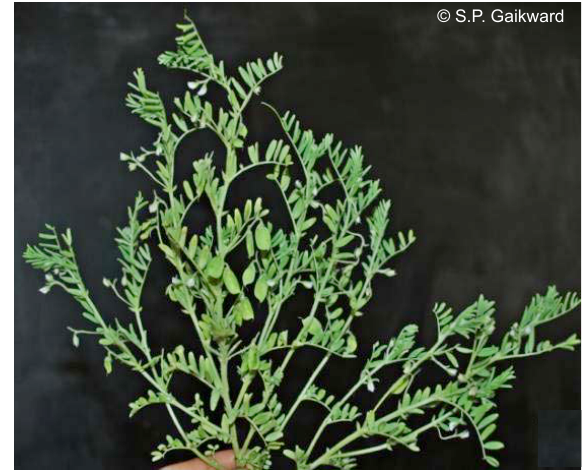
rachis terminating into tendril. Raceme 1–3